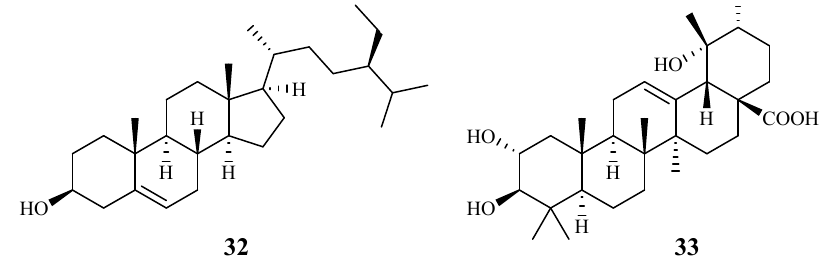
Figure 8. Compounds from a Cecropiaceae plant.